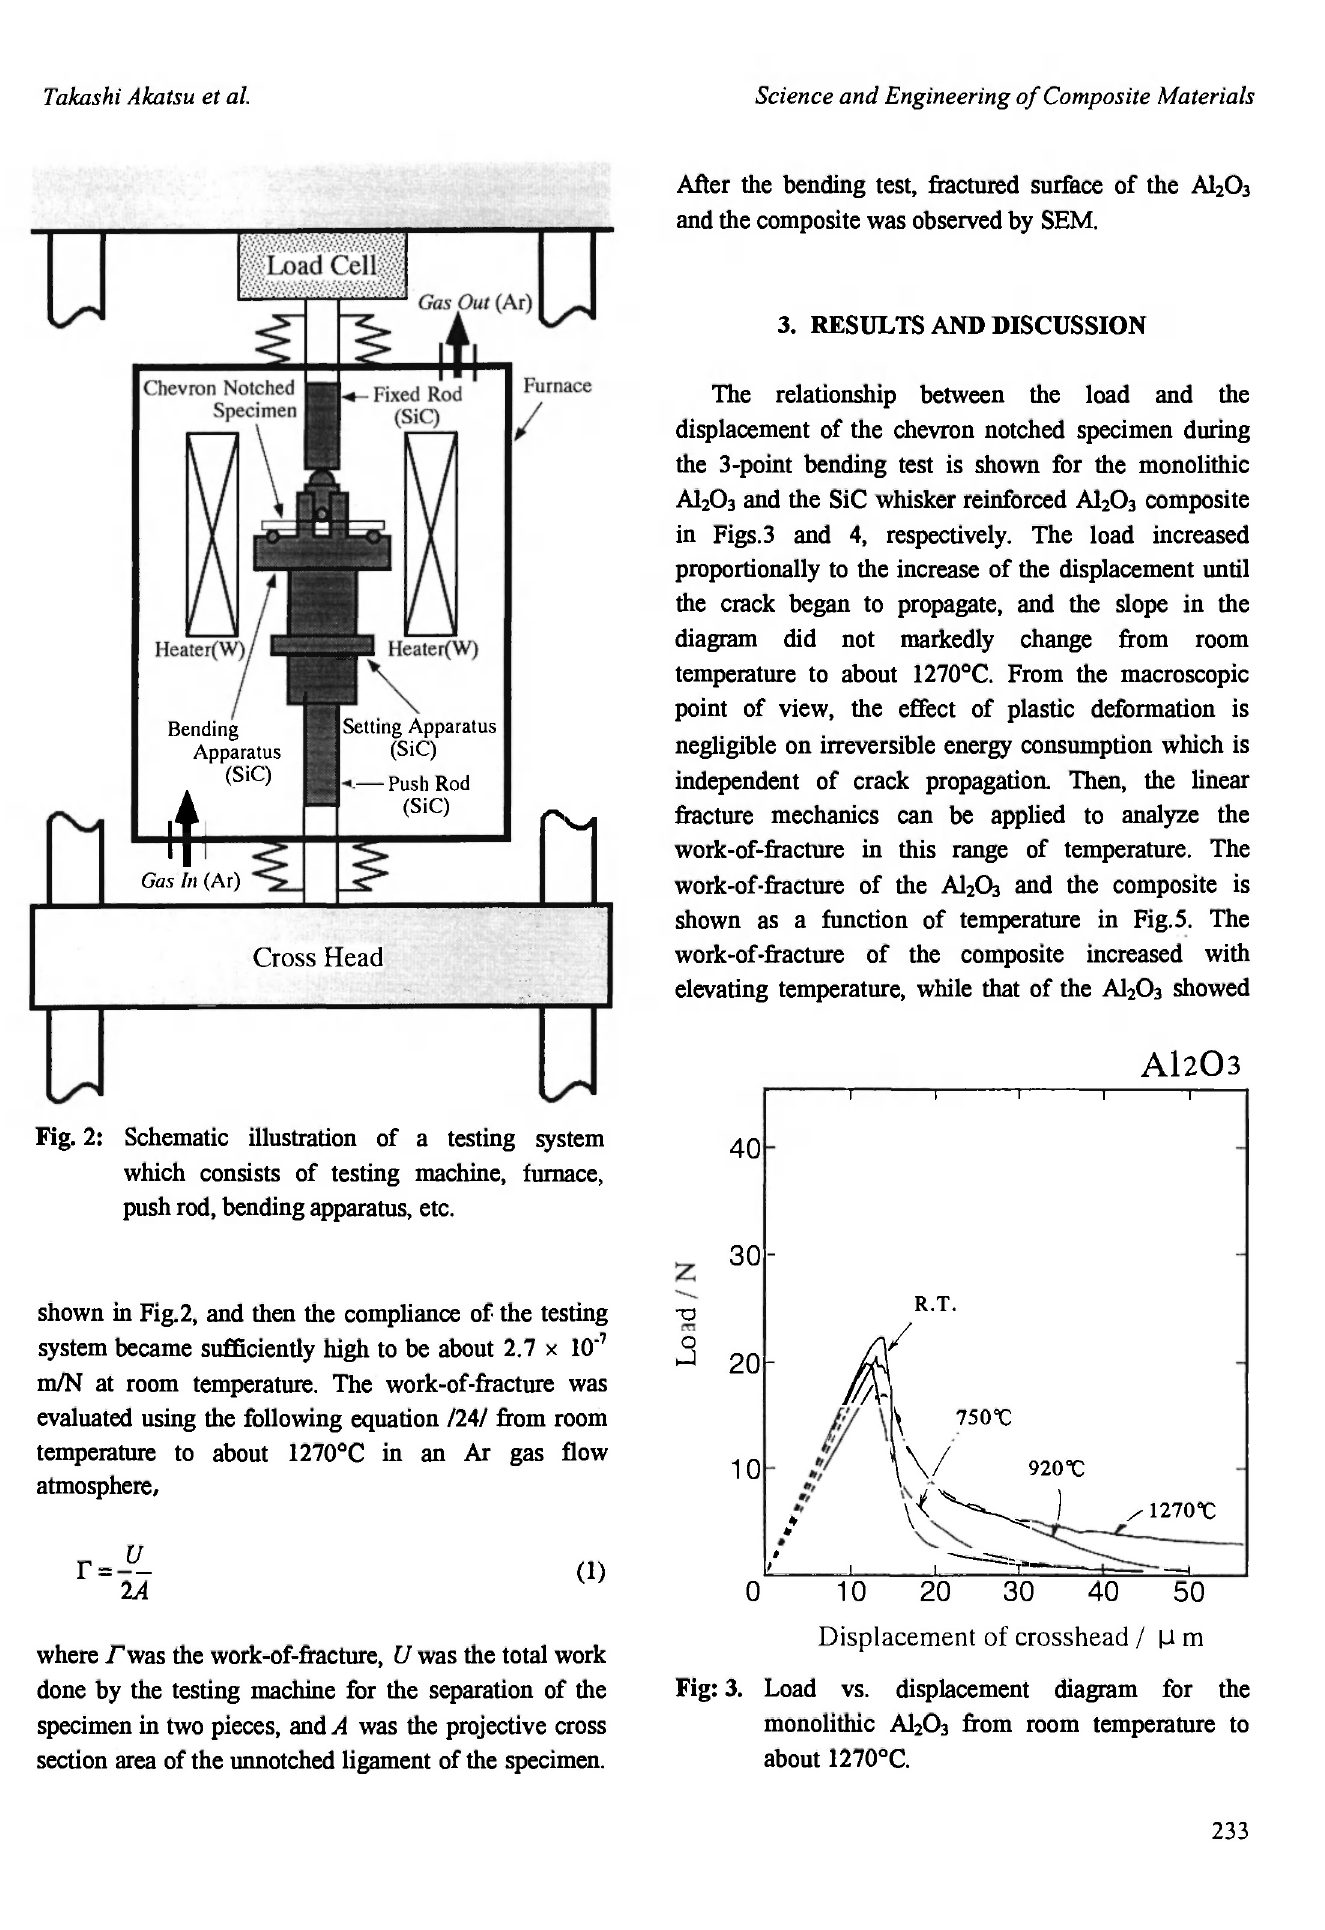
Fig. 2: Schematic illustration of a testing system which consists of testing machine, furnace, push rod, bending apparatus, etc.